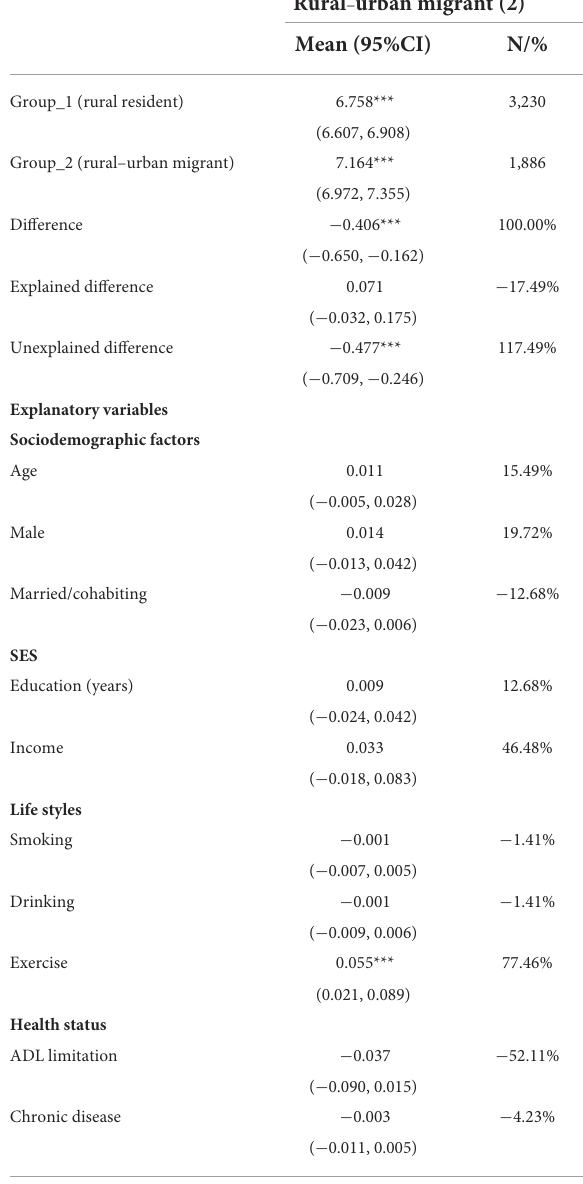
TABLE 6 Blinder–Oaxaca decomposition of the gap in depressive symptoms between the rural resident and rural–urban migrant samples (weighted).